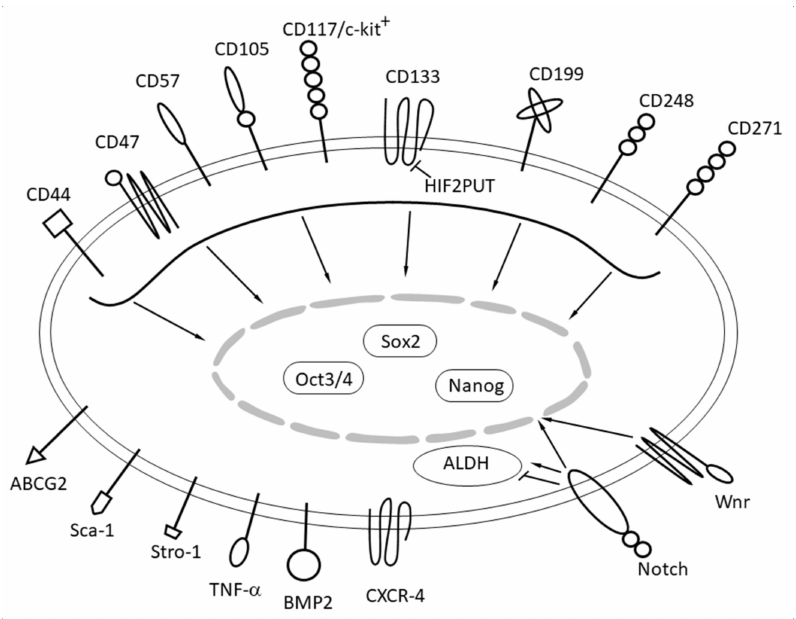
Figure 3. Overview of molecular markers of osteosarcoma tumor initiating